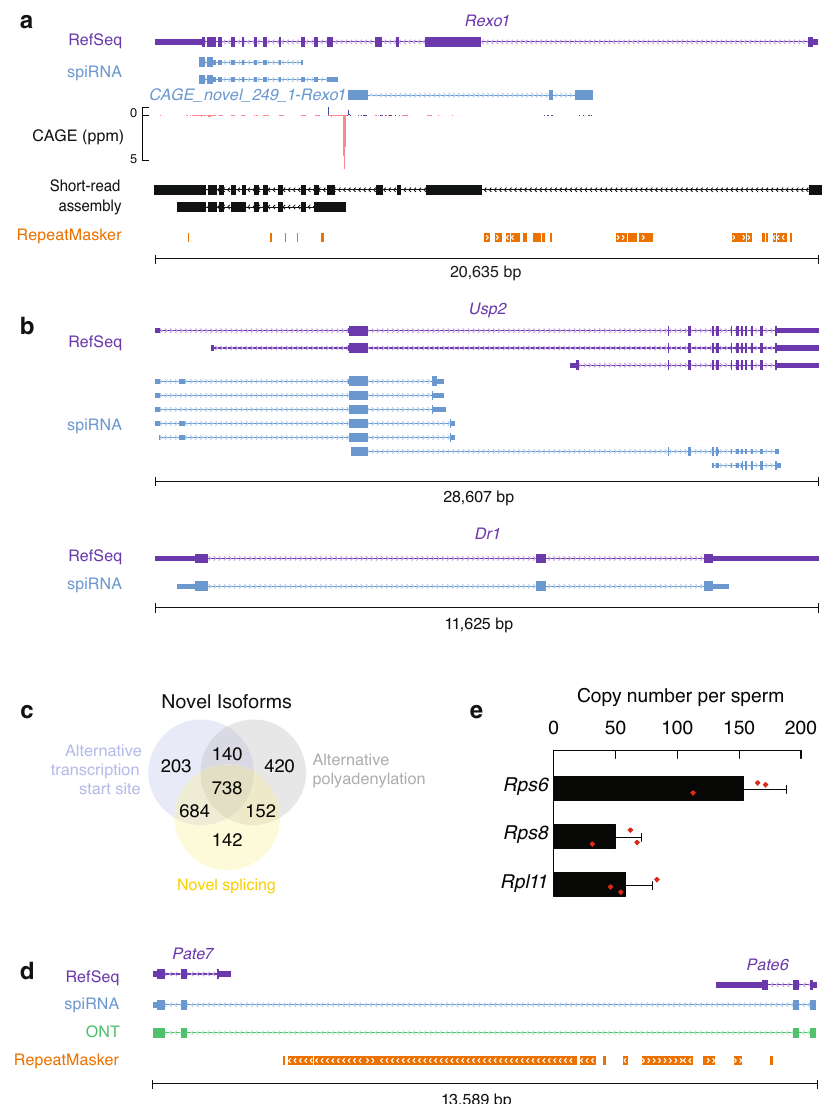
Fig. 2 Intact long RNA transcripts exist in sperm. a An example of a novel gene, CAGE_novel_249_1-Rexo1 , anti-sense to a known gene locus, Rexo1 , not supported by short-read assembly but detected by PacBio long reads and supported by CAGE, localized in a highly repetitive region of the genome. From top to bottom, RefSeq, spiRNA, CAGE reads (Blue represents Watson strand mapping reads; Red represents Crick strand mapping reads), short-read (SR) assembly, and RepeatMasker. Ppm, parts per million. b Two examples of novel transcript structures from known genes, Usp2 and Dr1 . From top to bottom, RefSeq and spiRNA. c Venn diagrams showing the contribution of alternative transcription start site, alternative splicing, and alternative polyadenylation to the isoforms that differ from RefSeq. d A spiRNA spans two neighboring annotated genes, Pate7 and Pate6 , which are separated by LINE1 elements. From top to bottom, RefSeq, spiRNA, ONT (Oxford Nanopore Technologies) sequencing reads, and RepeatMasker. e Copy number per sperm of spiRNAs, Rps6 , Rps8 and Rpl11 . The RNAs were quanti fi ed using in vitro transcribed RNAs as standards. Abundance of transcripts was quanti fi ed using RT-qPCR ( n = 3). Data are mean ± standard deviation. Source data of Fig. 2e are provided as a Source Data fi